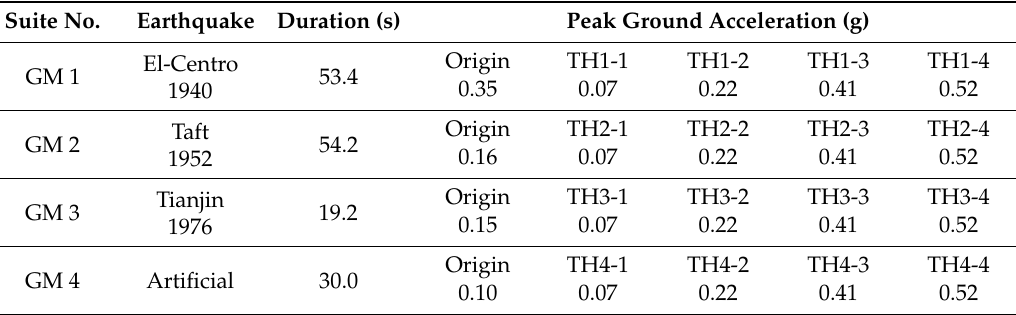
Table 3. Ground motion properties for nonlinear dynamic analysis (4 suites of 16 excitations). Suite No. Suite